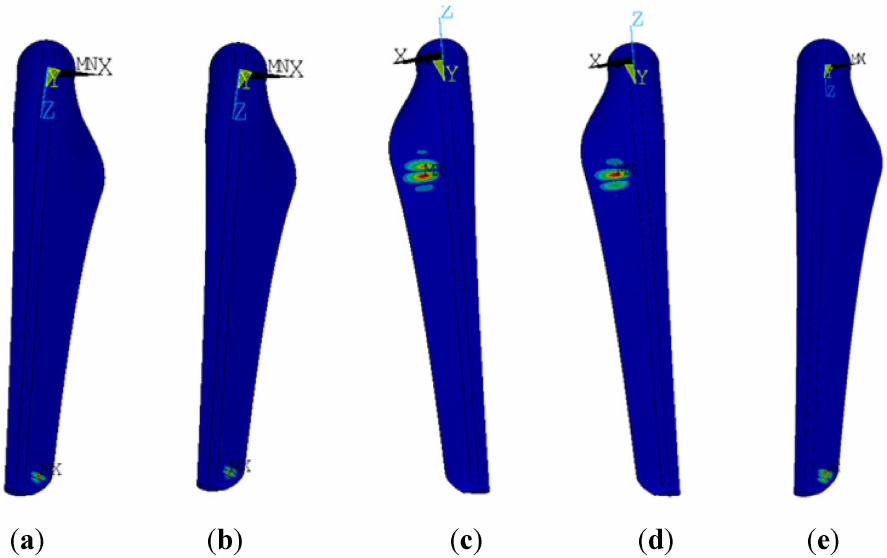
Figure 12. Eigen buckling under limit load ( a ) 1st mode; ( b ) 2nd mode; ( c ) 3rd mode; ( d ) 4th mode; ( e ) 5th mode. Wind speed 59 m/s.